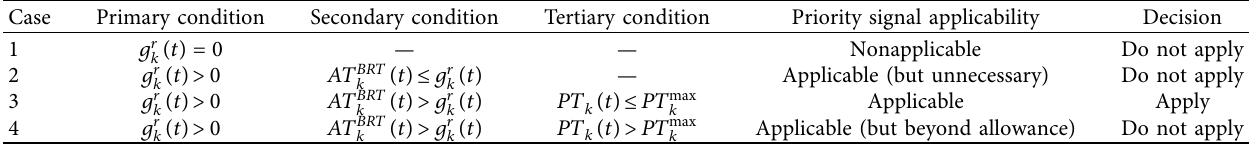
Table 4: Conditions for BRT signal priority